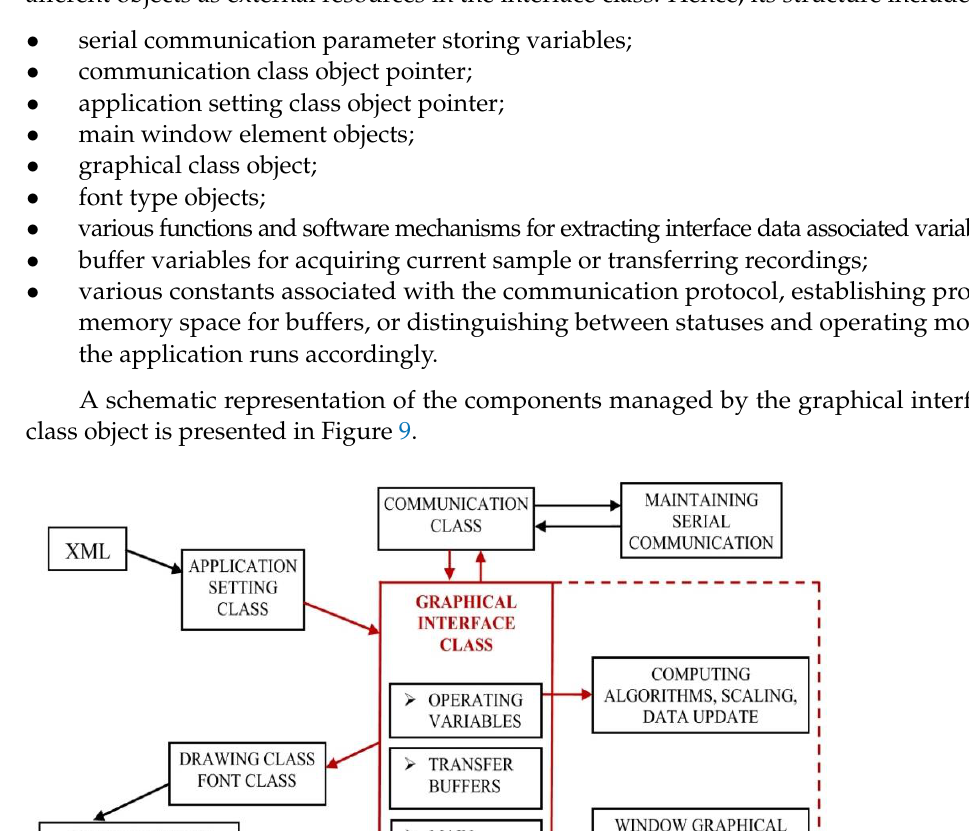
Figure 8. DIAG-02 user interface.